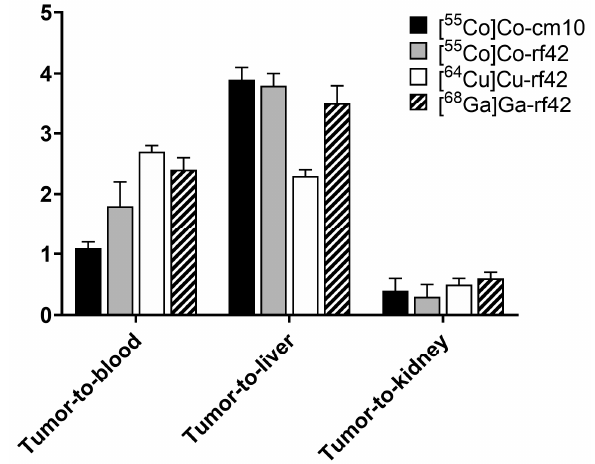
Figure 6. Tumor-to-organ ratios for previously reported complexes [ 64 Cu]Cu-rf42 and [ 68 Ga]Ga-rf42 in comparison to [ 55 Co]Co-rf42 and [ 55 Co]Co-cm10 [14].